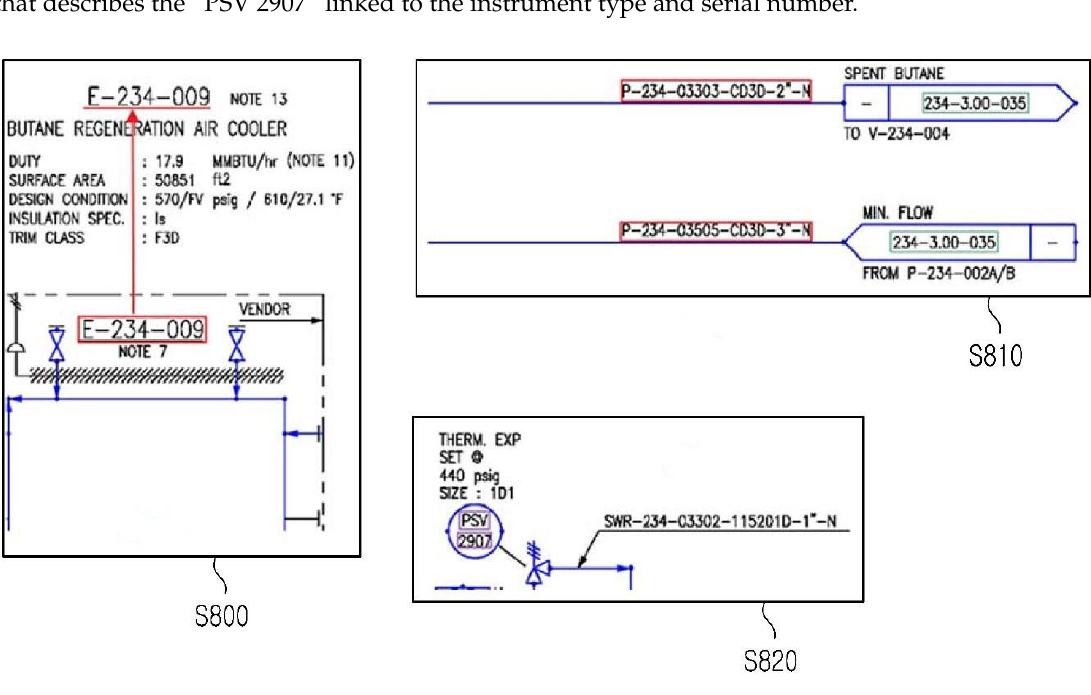
Figure 5. Connecting a symbol to a text.